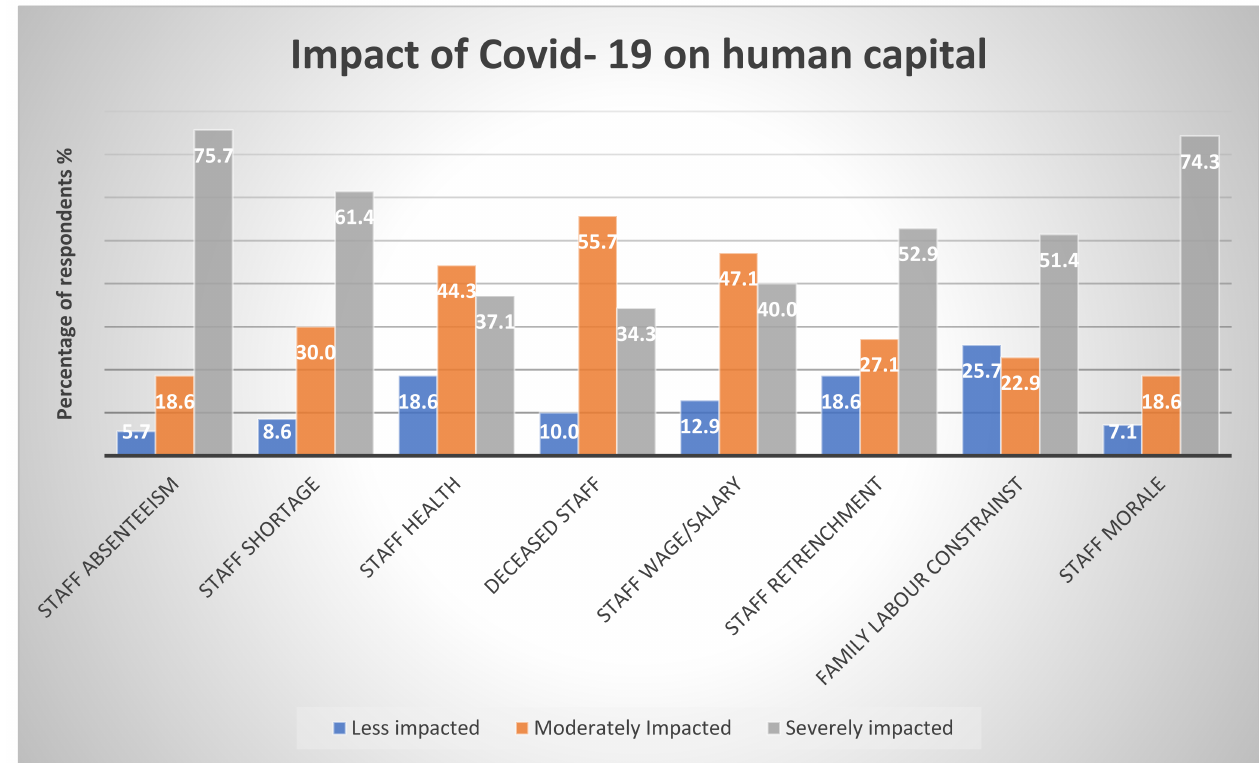
Figure 5. Degrees of impact for human